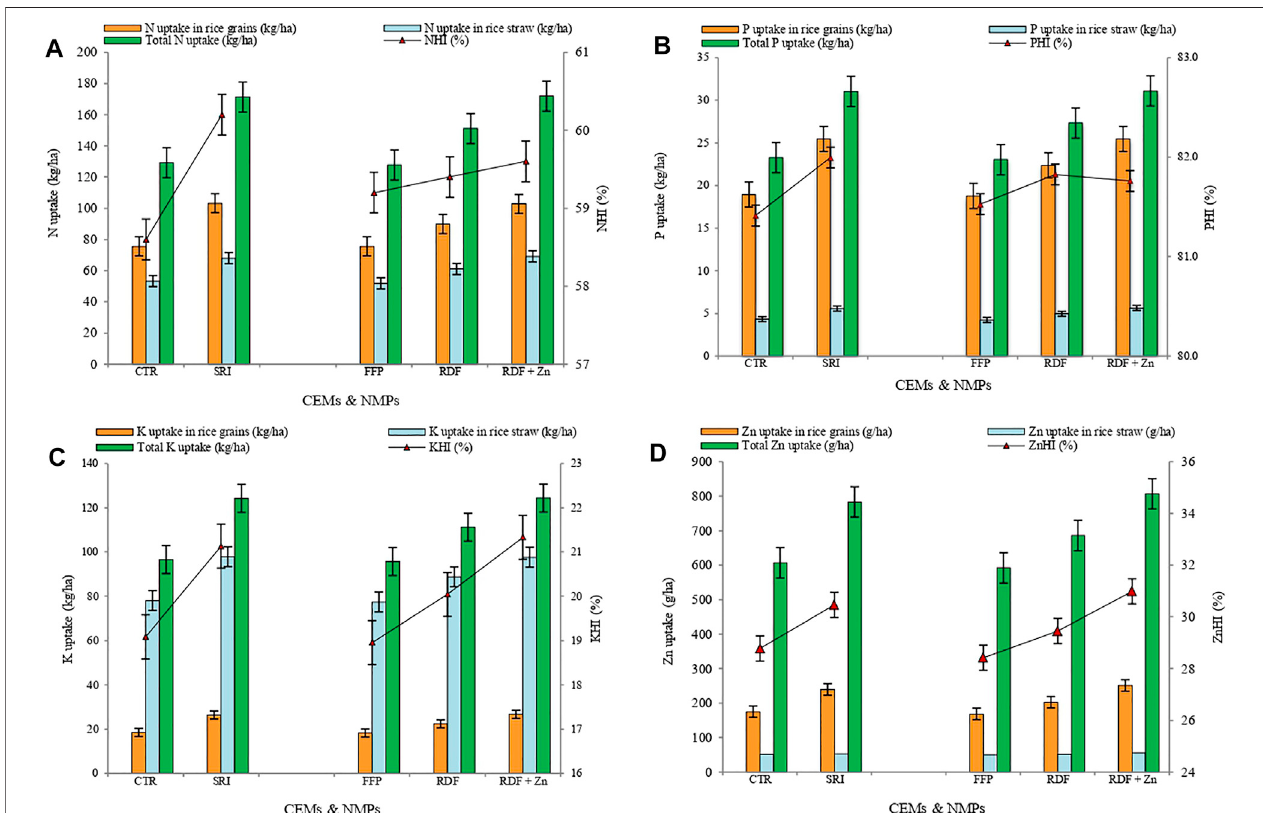
FIGURE6| In fl uenceofdifferentCEMsandNMPson (A) Nuptake, (B) Puptake, (C) Kuptake,and (D) Znuptakeinricegrainsandstrawandtotalnutrientuptake, and respective nutrient harvest indices (4 years av.). The vertical bars indicate the LSD at p = 0.05.